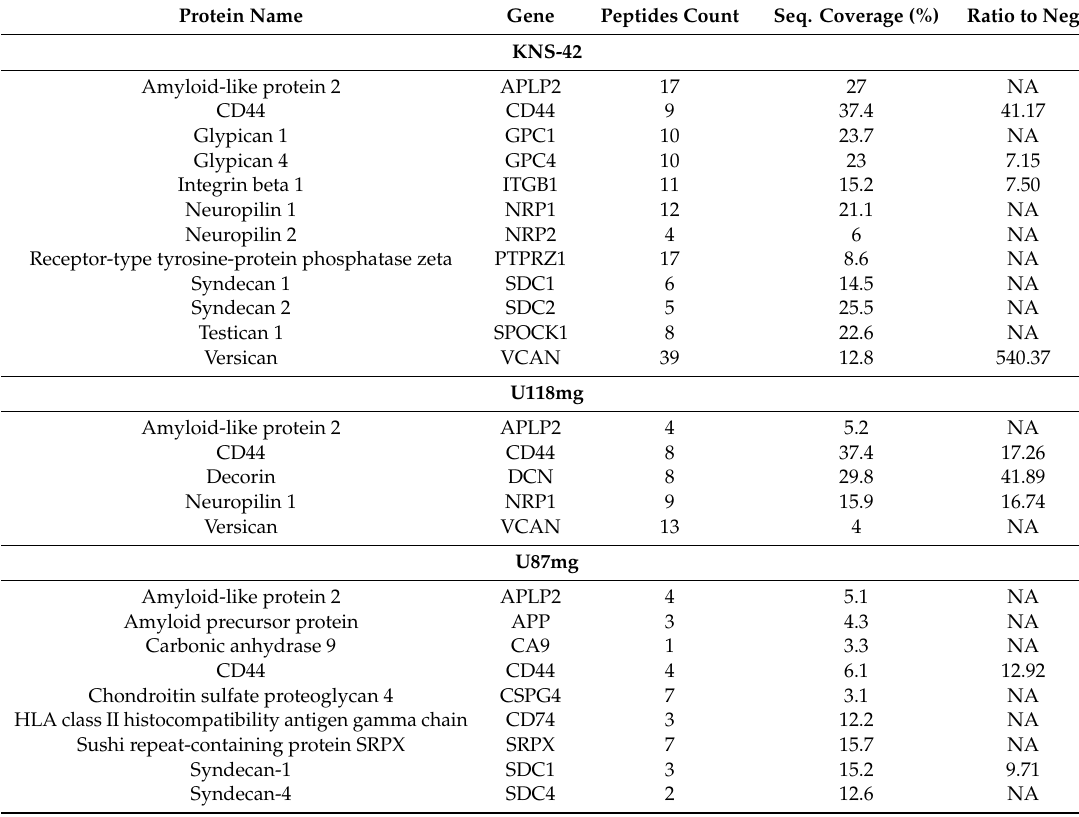
Table 1. rVAR2-based protein pull-down hits from cell